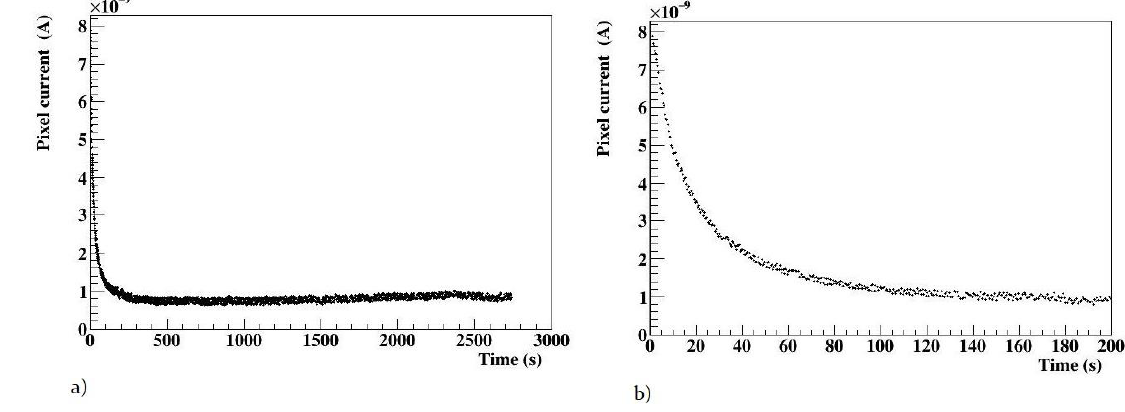
Figure 10. ( a ) Leakage current versus time in a 2700 s time scale, ( b ) leakage current versus time in a 200 s time scale.